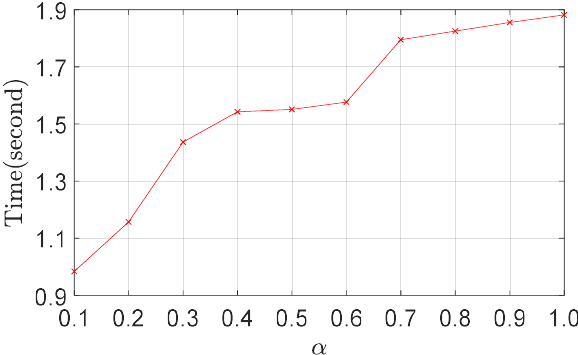
Figure 4. The effect of